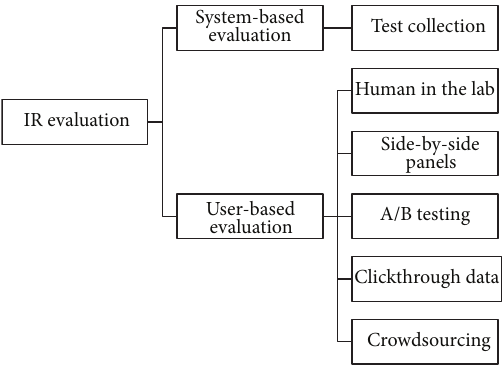
Figure 1: Classification of IR evaluation